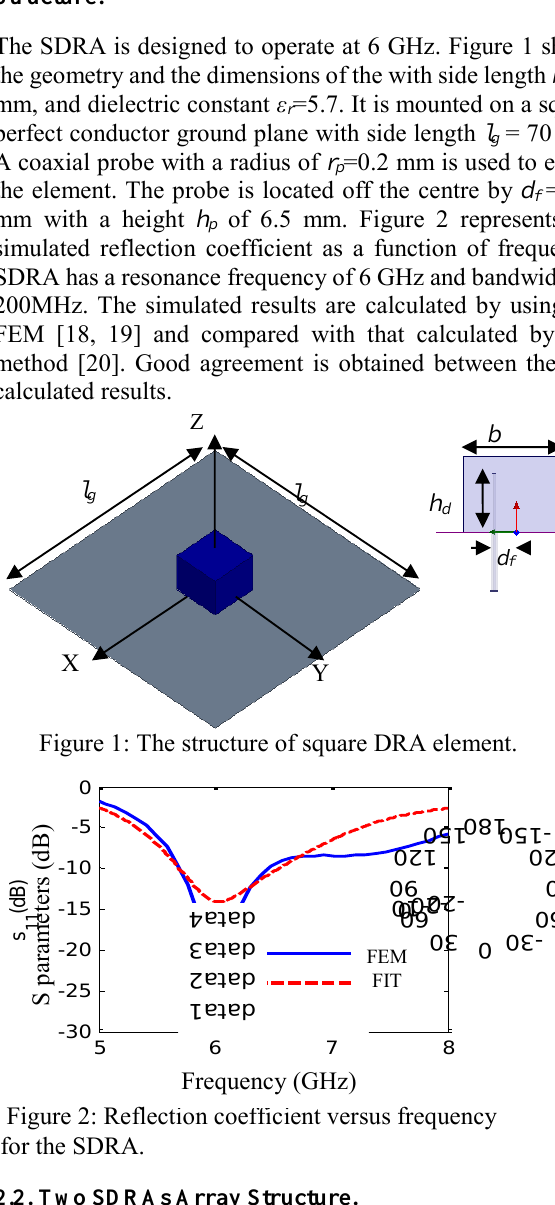
Figure 2: Reflection coefficient versus frequency for the